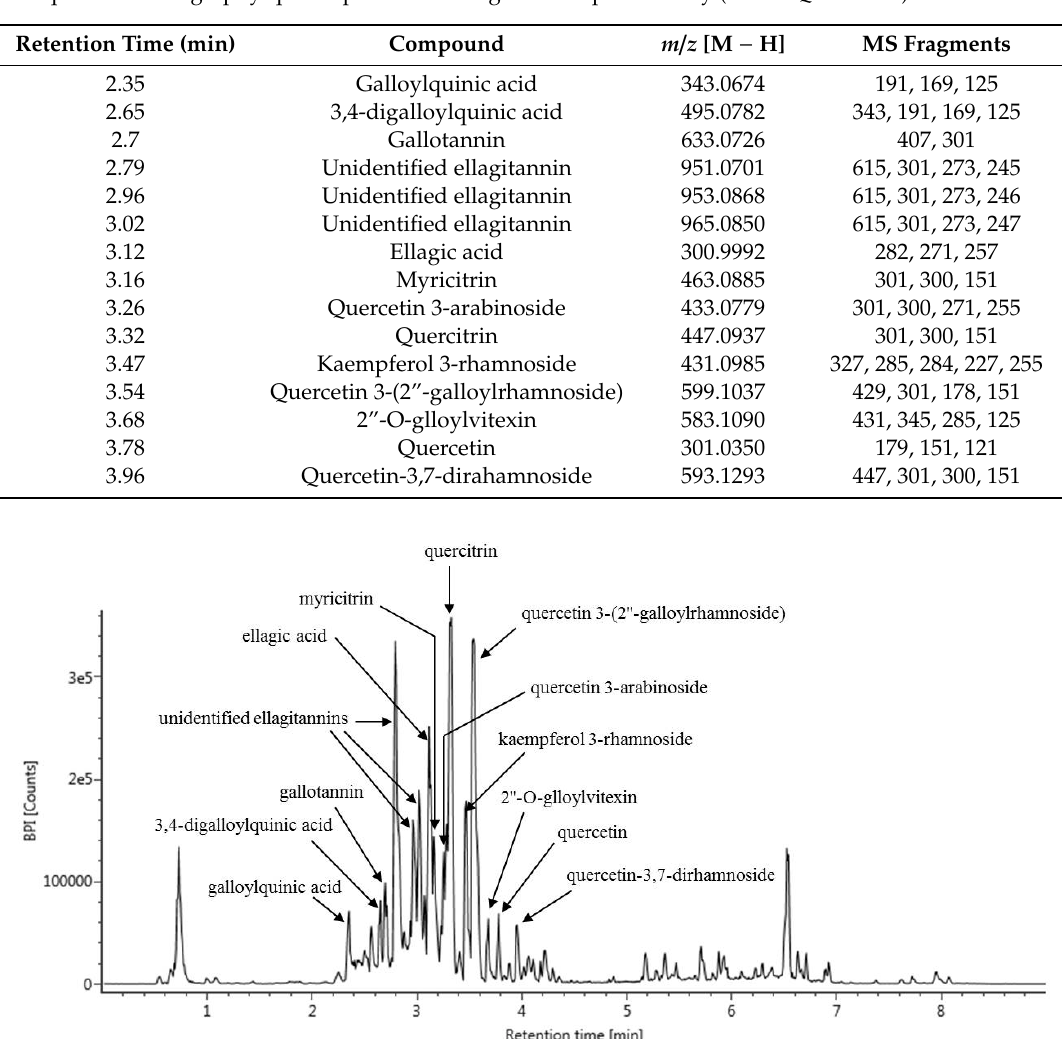
Figure 4. LC-MS chromatogram of C. turczaninowii extract and identification of major compounds. The extract was analyzed using a UPLC-Q-TOF MS with an Acquity UPLC BEH C 18 column (2.1 mm × 100 mm, 1.7 µ m) and negative electrospray ionization. The MS / MS spectra were obtained using collision energy ramps from 20 to 45 eV, and compounds were identified by the Unifi software with various LC / MS databases and by published papers. LC-MS: liquid chromatography mass spectrometry; MS / MS: tandem madss